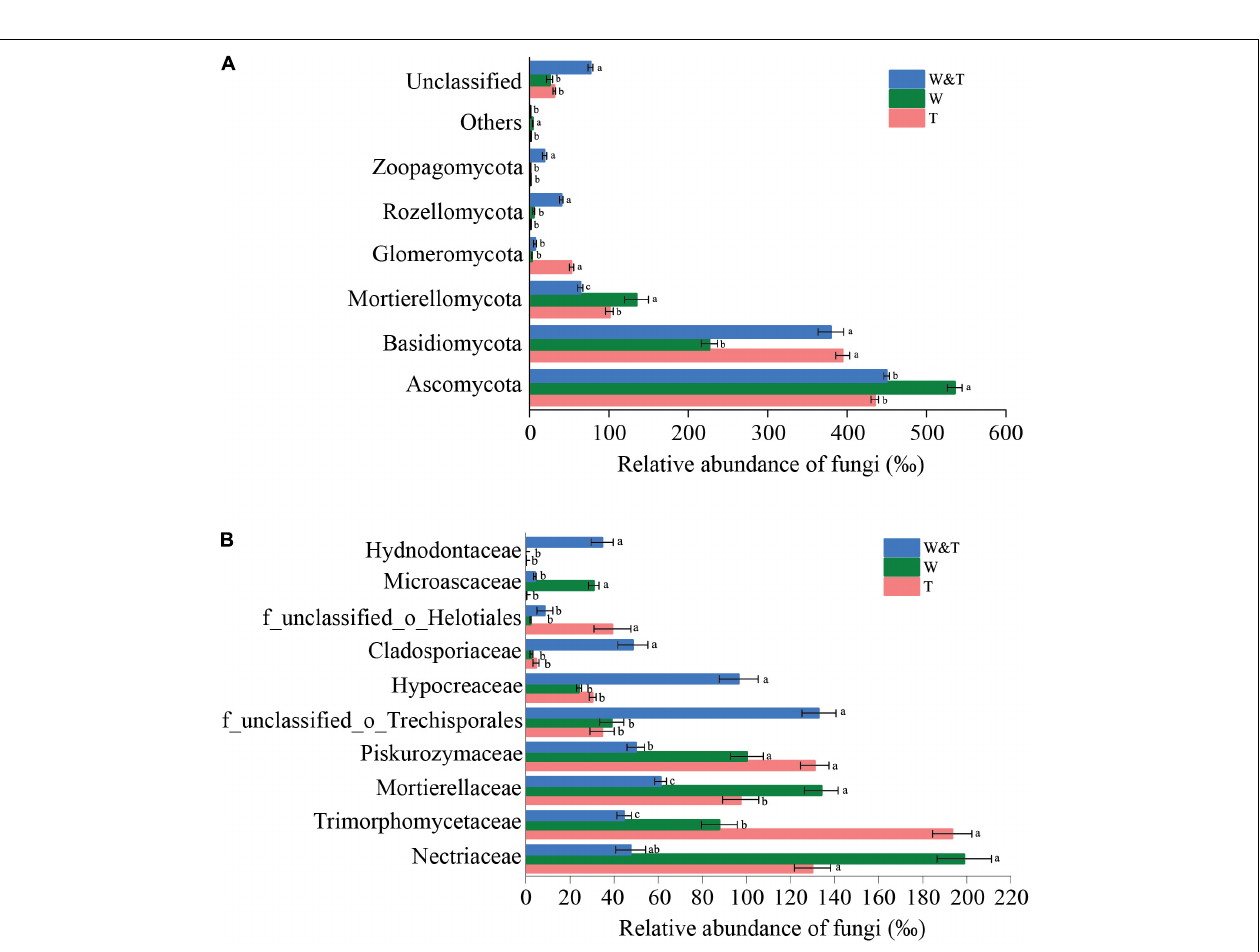
FIGURE 6 | Average relative abundance (RA) of the most dominant fungal phyla and families in the monoculture tea forest (T), monoculture walnut forest (W), and walnut–tea intercropping forest (W&T). (A) RA of fungal communities at the phylum level. (B) RA of fungal communities at the family level. Only operational taxonomic units (OTUs) with RA > 1% in at least one sample were included in the analysis. Different lowercase letters on each bar indicate the least significant differences (LSDs; p < 0.05) among T, W, and W&T treatments.